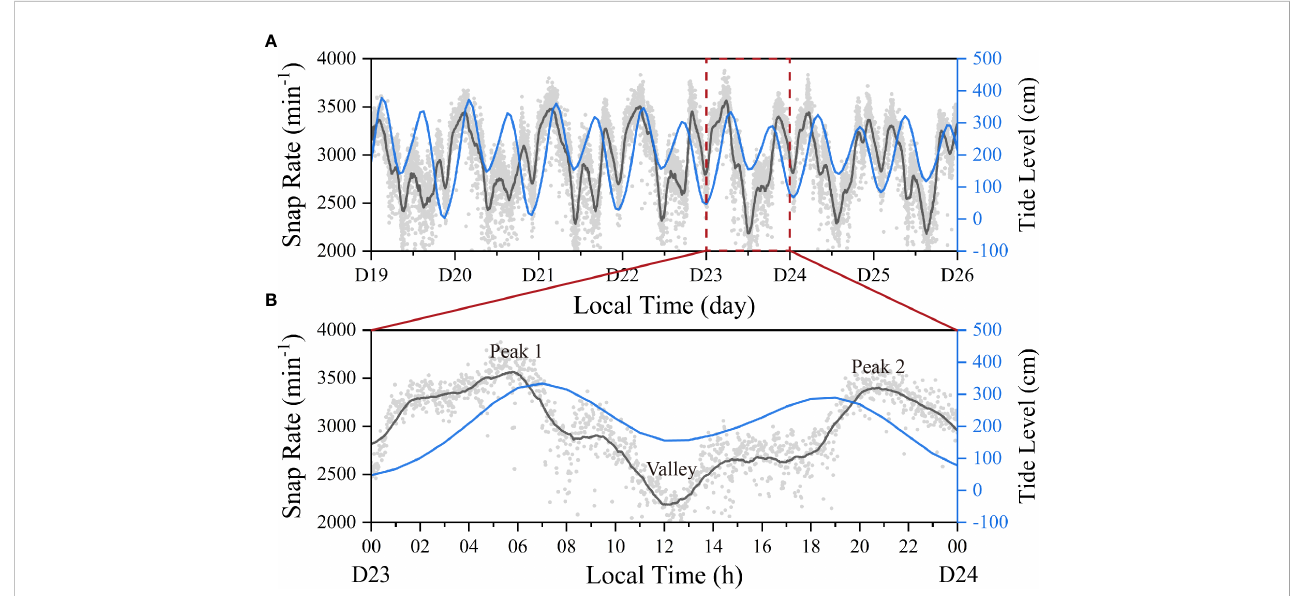
FIGURE 5 (A) Temporal variation of the snap rate extracted from Site 2 over a 7-day period (D 19 – D 26) and the change of tidal level. (B) An enlarged layout of the snap rate within a single recording